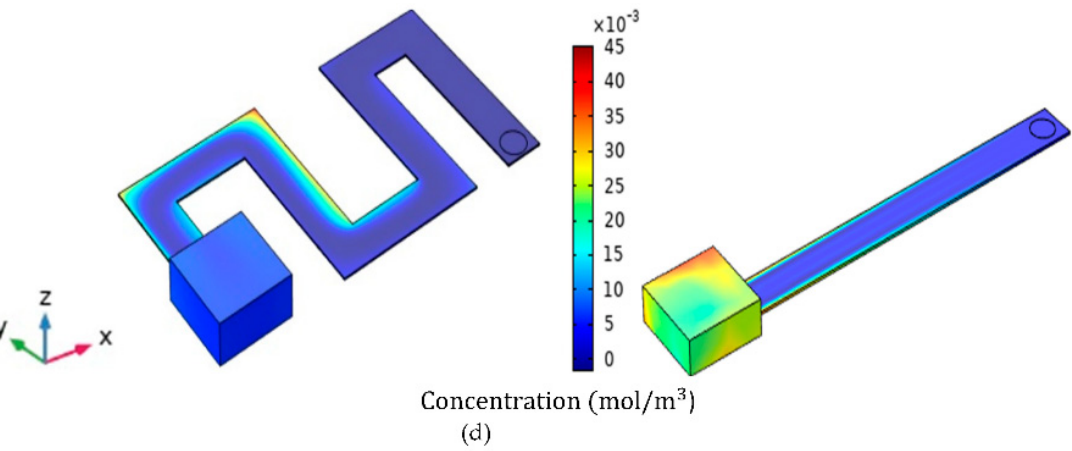
Figure 4. Visualization of the concentration profiles of the serpentine and simple models at the gas exposure and cutting times. ( a ) t = 0 s, ( b ) t = 25 s, ( c ) t = 40 s, ( d ) t = 100 s.